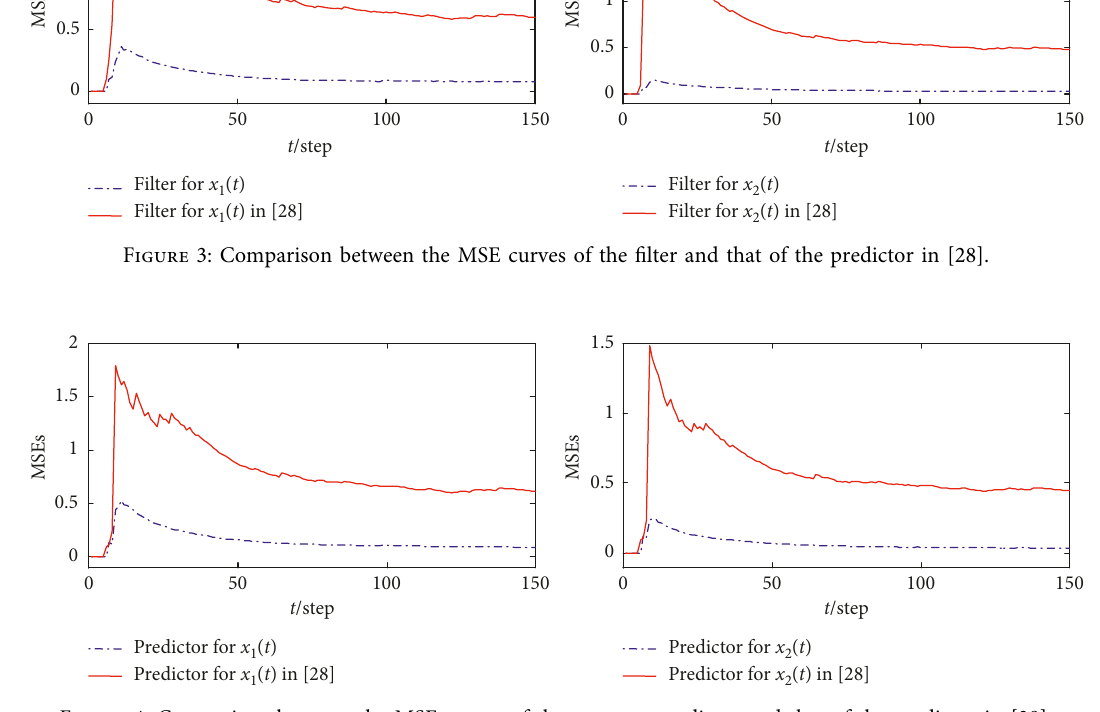
Figure 4: Comparison between the MSE curves of the one-step predictor and that of the predictor in [28]. Table 1: Comparison between the MSEs of the filter and that of